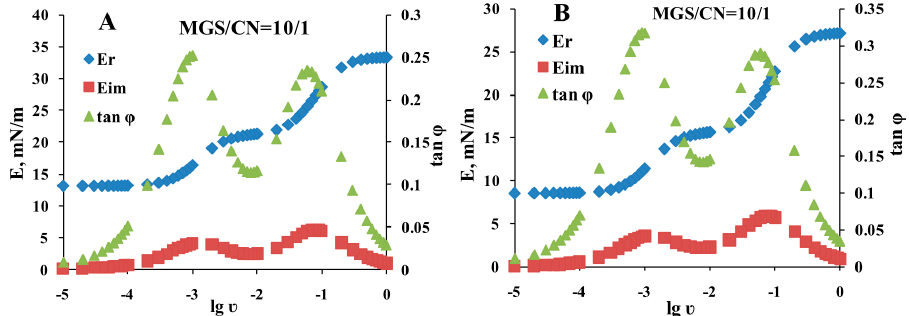
Figure 7. Representative Fourier transformations of typical relaxation transients. ( A ) fixed MGS amount; ( B ) constant total lipid. Data for rest of the film compositions are provided as electronic supplementary material.